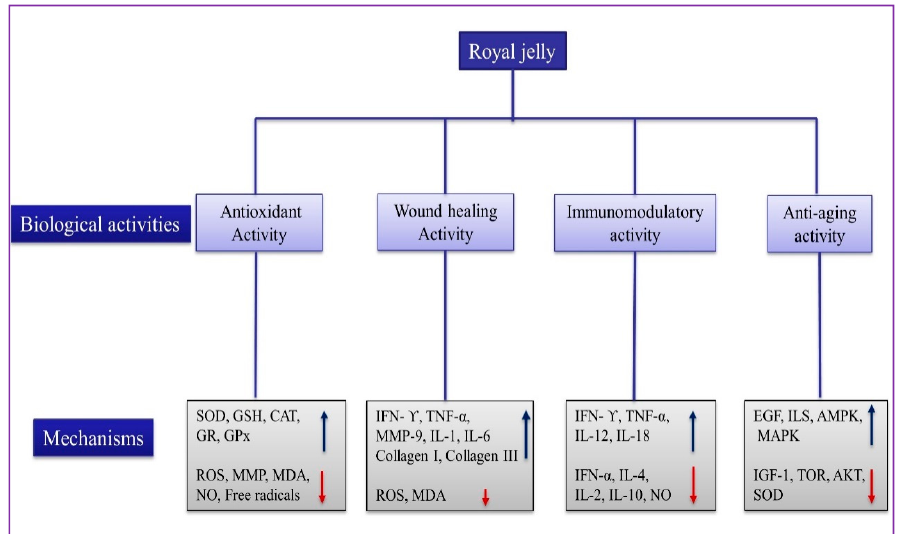
Figure 4. The biological activities of RJ and their mechanism. SOD (superoxide dismutase); GSH (glutathione); CAT (catalase); GR (glutathione reductase); GPx (glutathione peroxidase); ROS (reactive oxygen species); MMP (matrix metallopeptidases); MDA (malondialdehyde); NO (nitric oxide); IFN- Υ (interferon-gamma); IL-4 (interleukin-4); TNF- α (tumor necrosis factor); IFN- α (Interferon- α ); EGF (epidermal growth factor); AMPK (5 (cid:48) AMP-activated protein kinase); MAPK (mitogen-activated protein kinase); IGF-1 (insulin-like growth factor-1), and TOR (target of